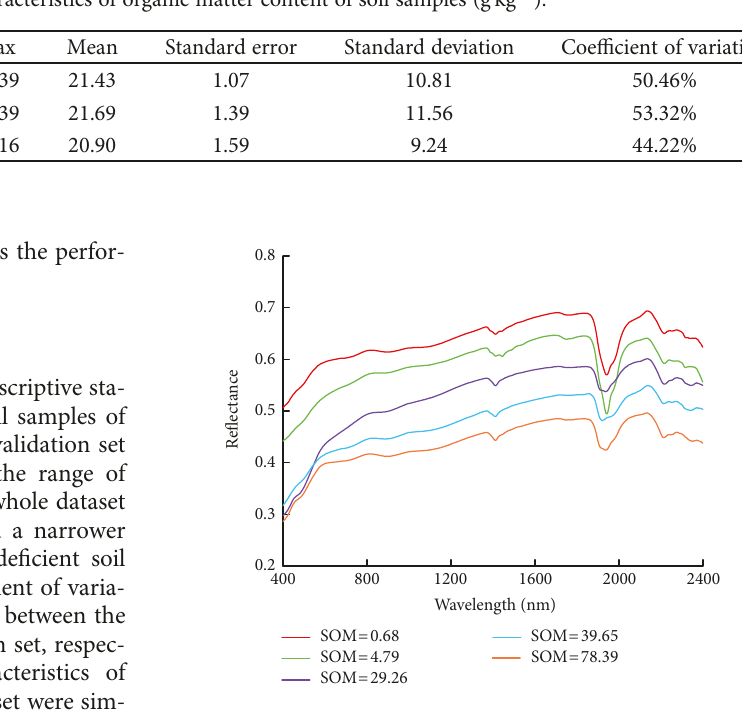
Figure 3: Spectral re fl ectance of soils with di ff erent organic matter content in the Ebinur Lake basin (gkg − 1